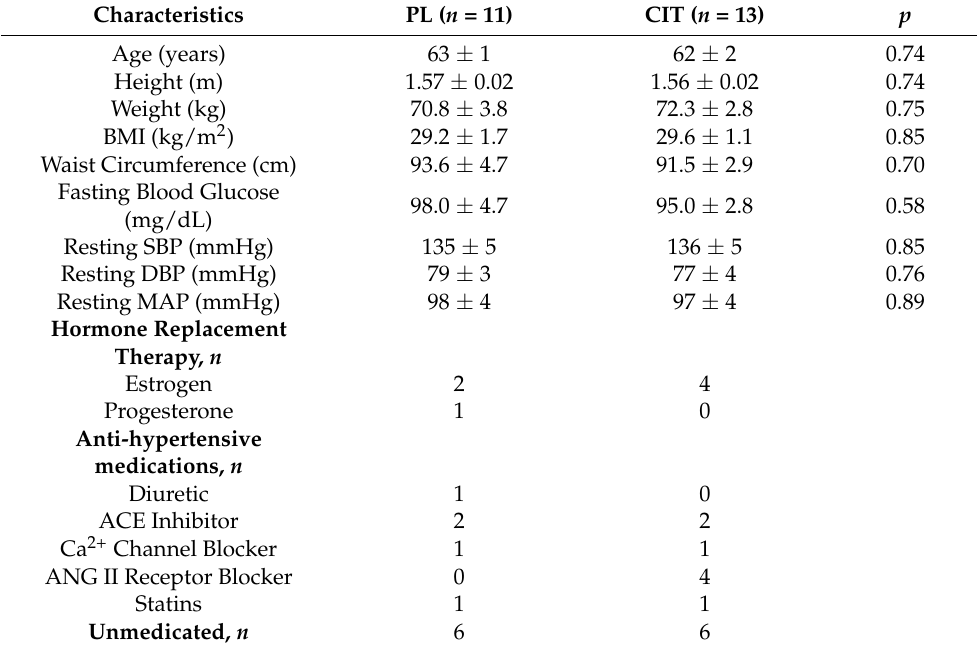
Table 1. Participant characteristics and